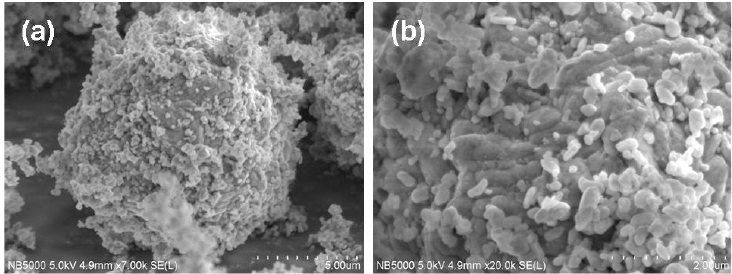
Figure 5. SEM images of the LiNi 1/3 Mn 1/3 Co 1/3 O 2 –LiFePO 4 (NMC–LFP) (70:30) blend powders showing ( a ) big NMC particle surrounded by nano-sized LFP and ( b ) a detail of the blend.